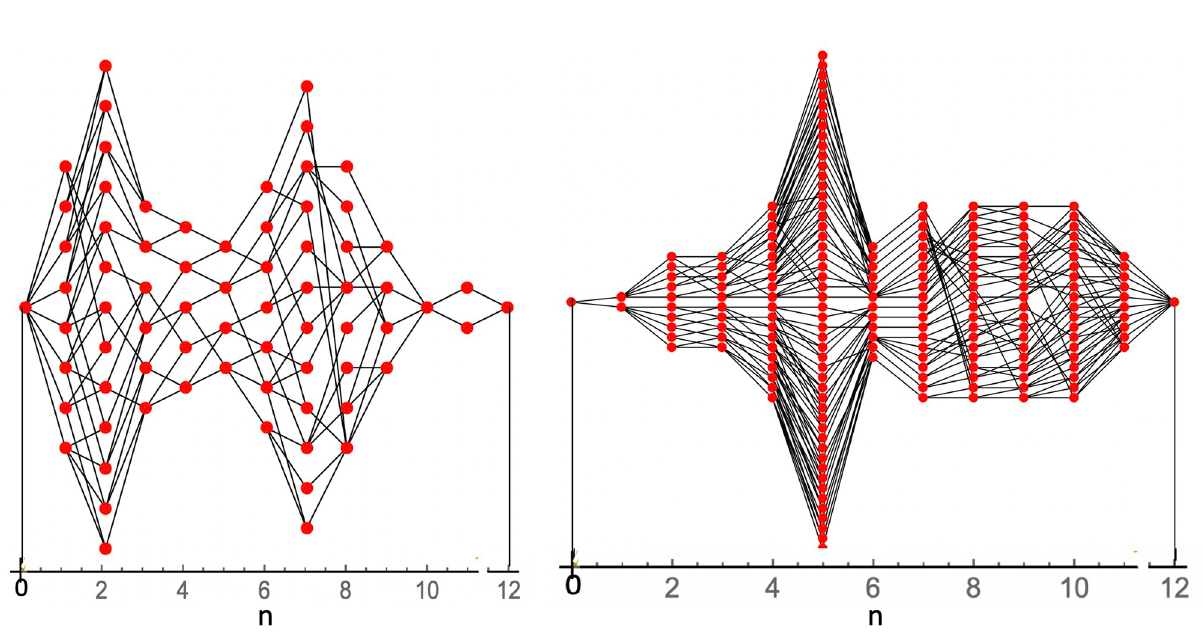
Fig 6. Examples of minimum energy assembly paths of an N = 8, MLD = 9 spanning tree (left) and an N = 2, MLD = 19 spanning tree (right). A P P node (indicated by a dot) indicates a physically distinct intermediate structure with, from left to right, n = 0, 1, ... ., 12 pentamers. The number m n of vertical dots for given n is the multiplicity , i.e., the number of distinct n-pentamer intermediates. A link connecting two nodes indicates that the two states are related by addition or removal of a pentamer. Every possible path from n = 0 to n = 12, including back steps, represents a possible minimum energy assembly pathway. During assembly there is a net current from the n = 0 initial state to the n = 12 final state while in thermal equilibrium the net current across every link is zero.